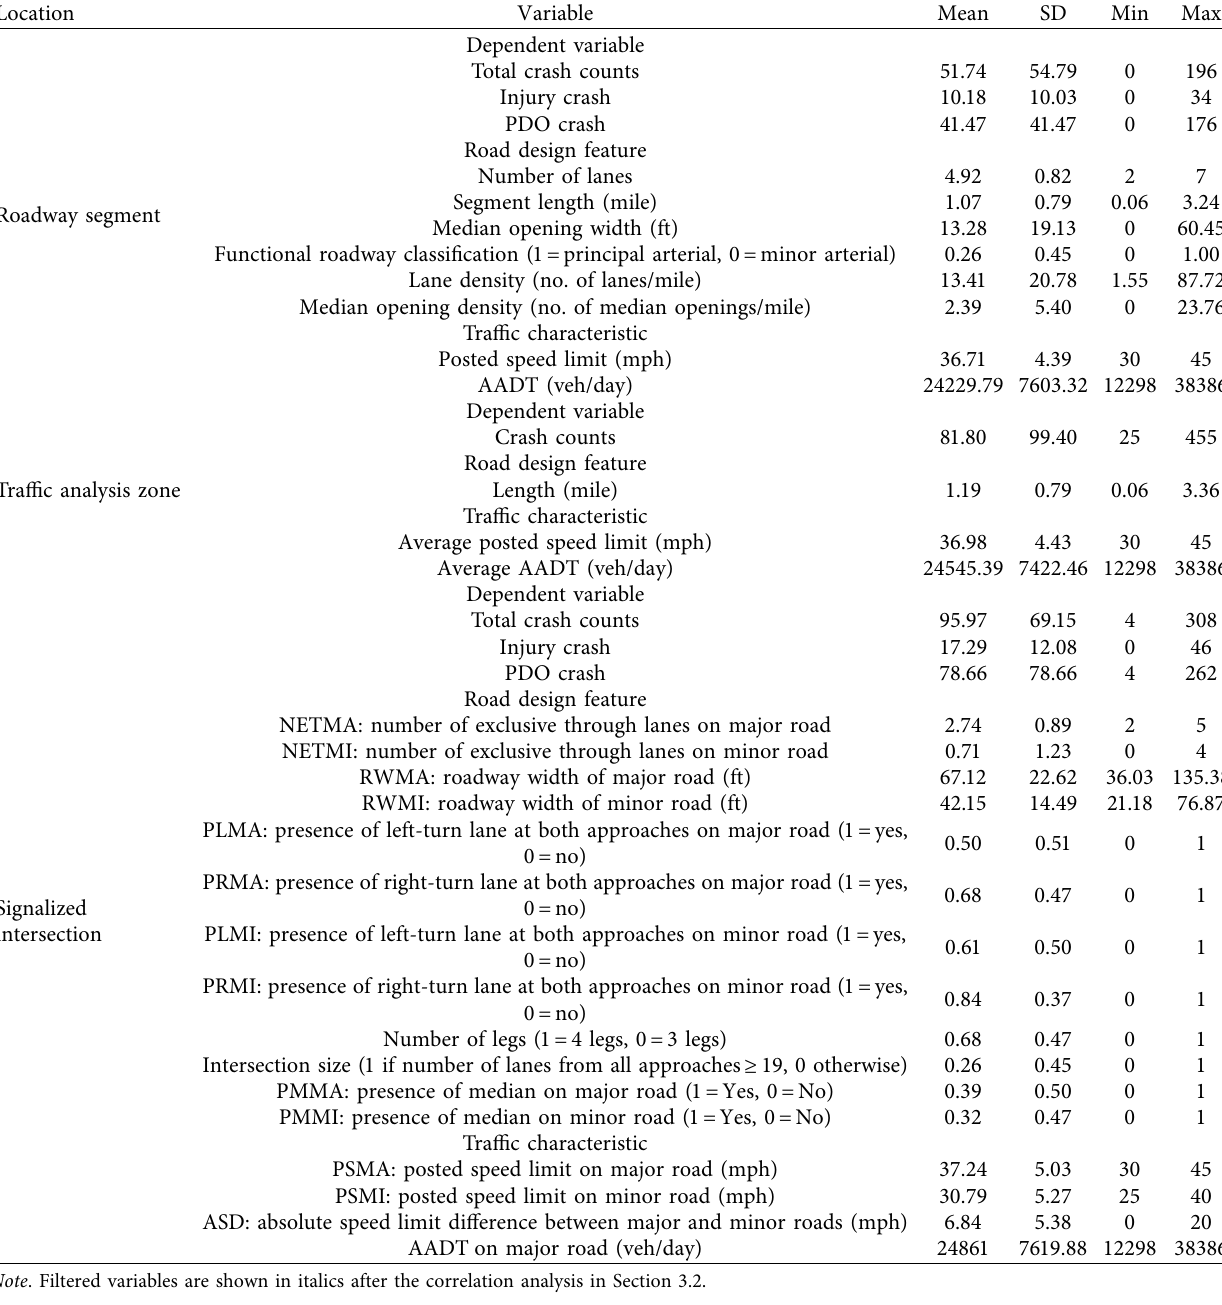
Table 1: Descriptive statistics of coordinated